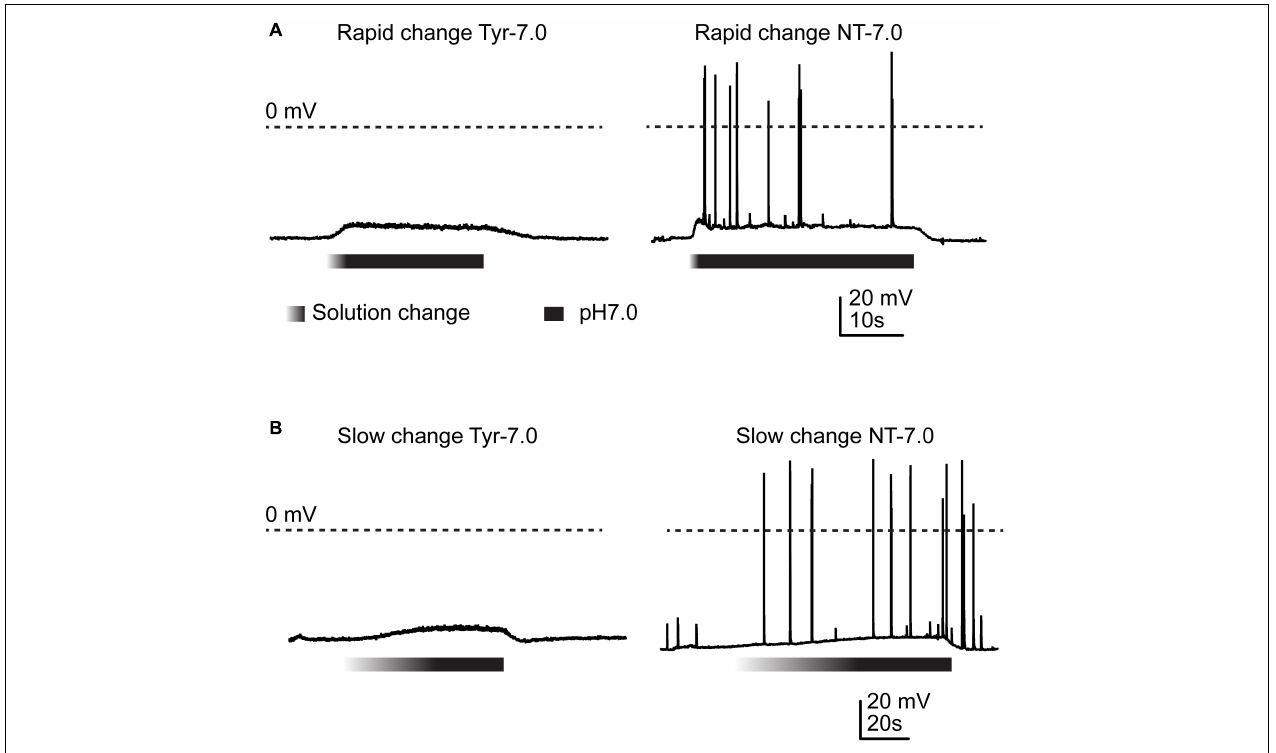
FIGURE 1 | Action potential induction by changes in Ca 2 + and K + concentration. Current-clamp experiments with cortical neurons. Baseline current was injected to obtain a resting membrane potential close to –60 mV in the pH7.4 Tyrode (Tyr) solution. Solution change from Tyr solution at pH7.4 to either Tyr solution at pH7.0 or “neurotransmission” (NT) solution at pH7.0. The Ca 2 + and K + concentrations of the Tyr solution were 2 and 4 mM, respectively, and those of the NT solution 1 and 6 mM. The gradient part of the bar indicates the pH ramp, the black part the perfusion with pH7.0. (A) Rapid changes, (B) slow